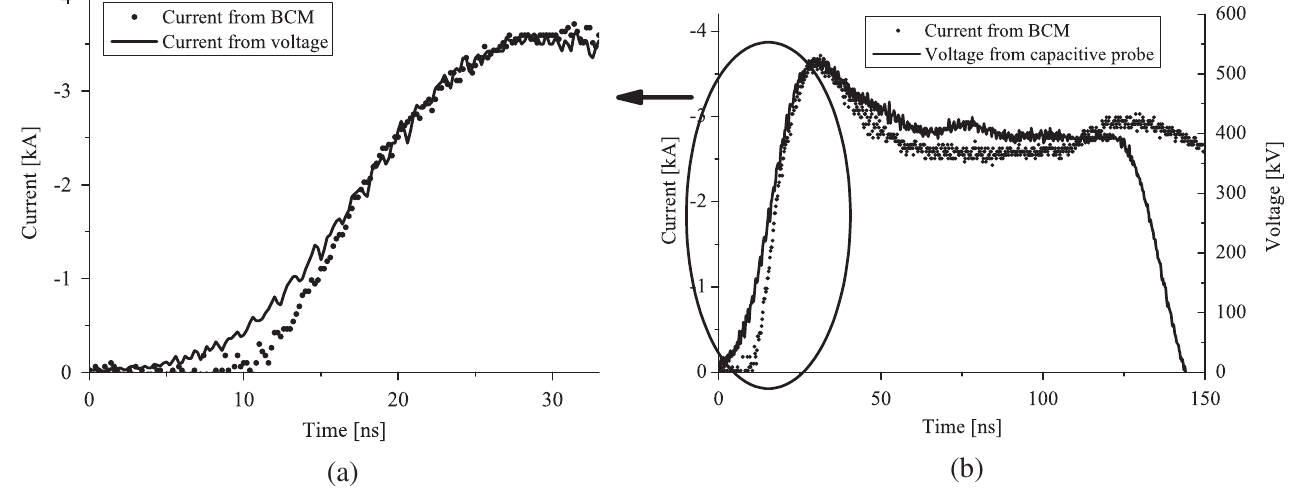
FIG. 2. (a) Comparison of the measured current (dots) with the space-charge limited current (curve) which was obtained from the applied voltage and the Child-Langmuir law with 9 : 8 (cid:1) P during 30 ns of rising time. (b) Voltage (vertical axis on the right-hand side) measured from the capacitive probe and the current (vertical axis on the left-hand side) from BCM for the supplied voltage with rising time of 30 ns and peak voltage of 530